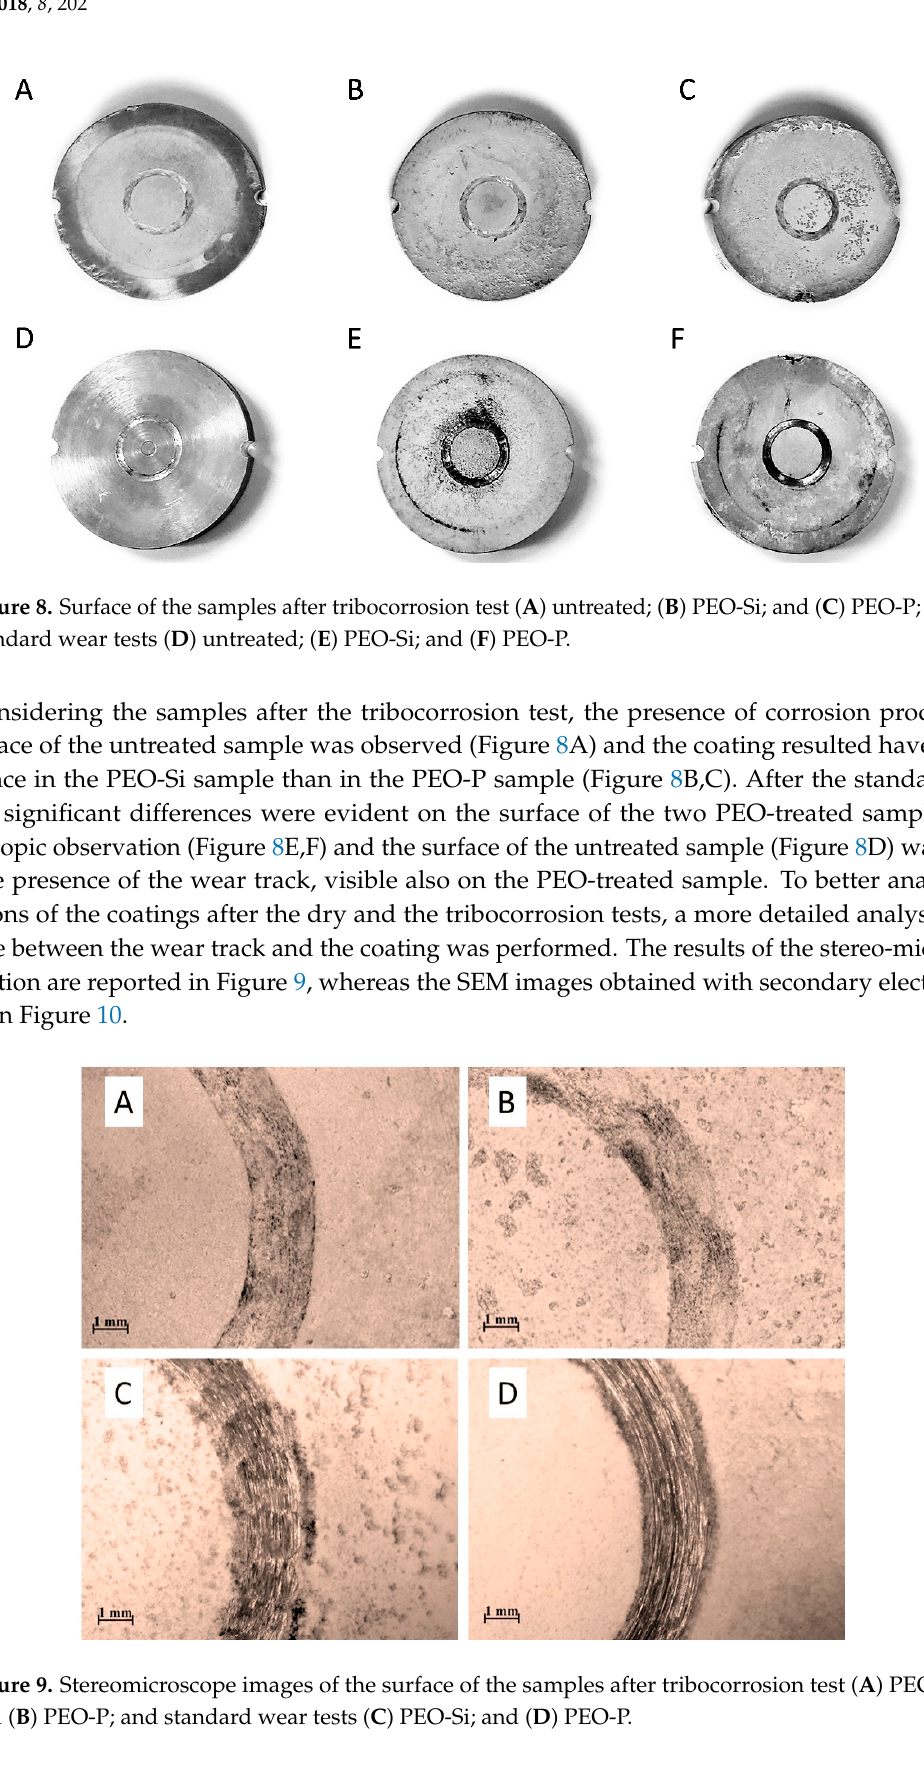
Figure 10. SEM-SE images (secondary electrons) of the surface of the samples after the tribocorrosion test ( A ) PEO-Si; and ( B ) PEO-P; and standard wear tests ( C ) PEO-Si; and ( D ) PEO-P. After tribocorrosion tests, the interface between the wear track and the coating in the PEO-P sample was totally damaged and detached, whereas the coating of the PEO-Si sample was remarkably more adherent and undamaged (Figures 9A,B and 10A,B). This fact can be ascribed to a different mechanism of corrosion in the two samples. As a matter of fact, Liang et al. [29] found that in PEO samples, obtained in phosphate solution, corrosion products formed at the interface between the substrate and coating, leading to the detachment of the latter, whereas in PEO samples, obtained in silicates solution, the corrosion products formed only in the pores of the coating After the standard dry tests the situation is different; in fact, the interfaces between the wear track and the coating in the PEO-P and PEO-Si samples were similar (Figures 9C,D and 10C,D), suggesting that the adhesion of the coating on the substrate and its mechanical properties were not influenced by the type of the electrolyte used in the PEO process, in agreement with the micro-hardness test. Therefore, the